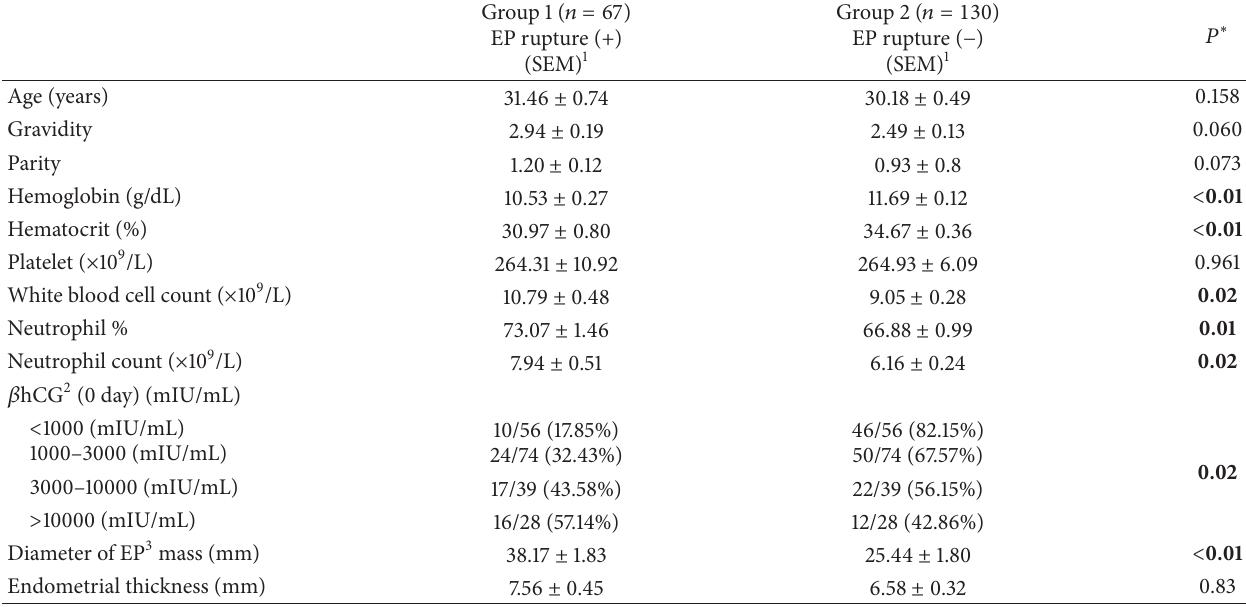
Table 1: Clinical parameters of rupture and nonrupture groups in